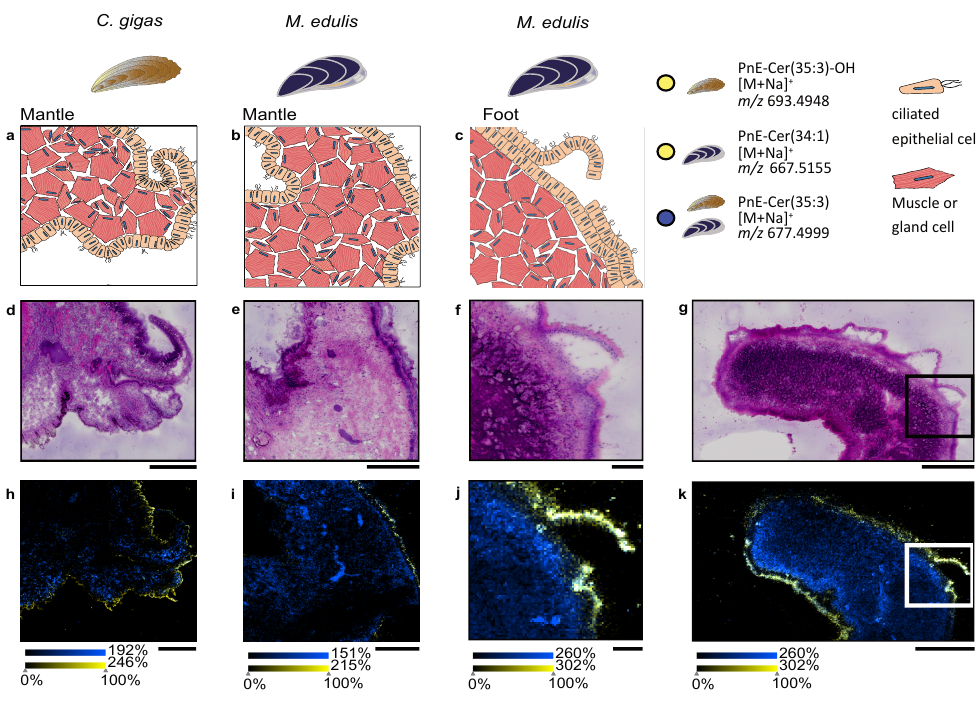
Figure 3 Tissue distributions of two different phosphonolipids. (A–C) Schematic overviews of tissue sections, histology of C. gigas mantle (D), M. edulis mantle (E), M. edulis foot (F, G), tissues stained with H&E. Distribution of phosphonolipids in (H–K) both epithelia-specific phosphonolipids in yellow, ubiq- uitous phosphonolipid in blue. (H) yellow: PnE-Cer(35:3)-OH ( m/z 693.4948 [M+Na] + ), (I–K) yellow: PnE-Cer(34:1) ( m/z 667.5155 [M+Na] + ). (H–K) blue: Pne-Cer(35:3) ( m/z 677.4999 [M+Na] + ). Scale Full-size DOI: